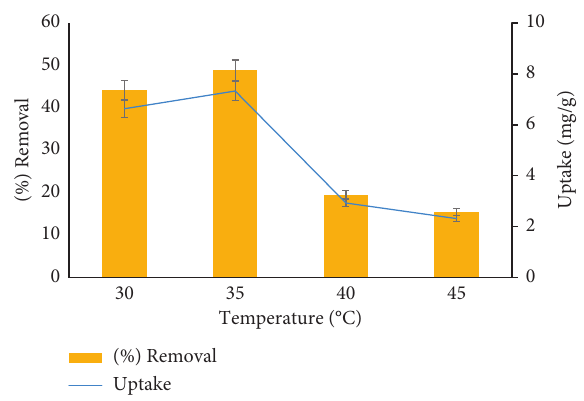
Figure 5: Effect of temperature on RY145 removal and sorption.